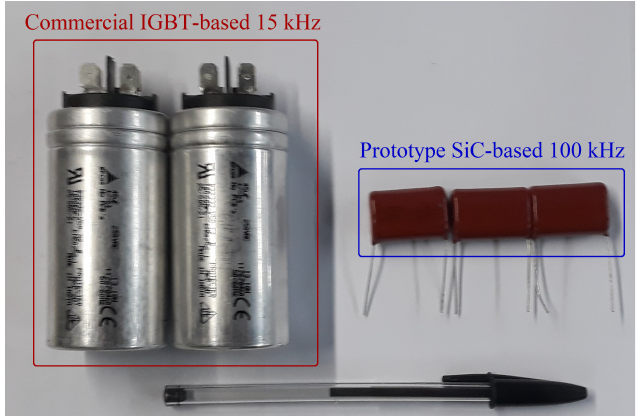
Figure 12. Size comparison between filter capacitors for the developed SiC-based prototype and for a commercial IGBT-based UPS with the same specifications.